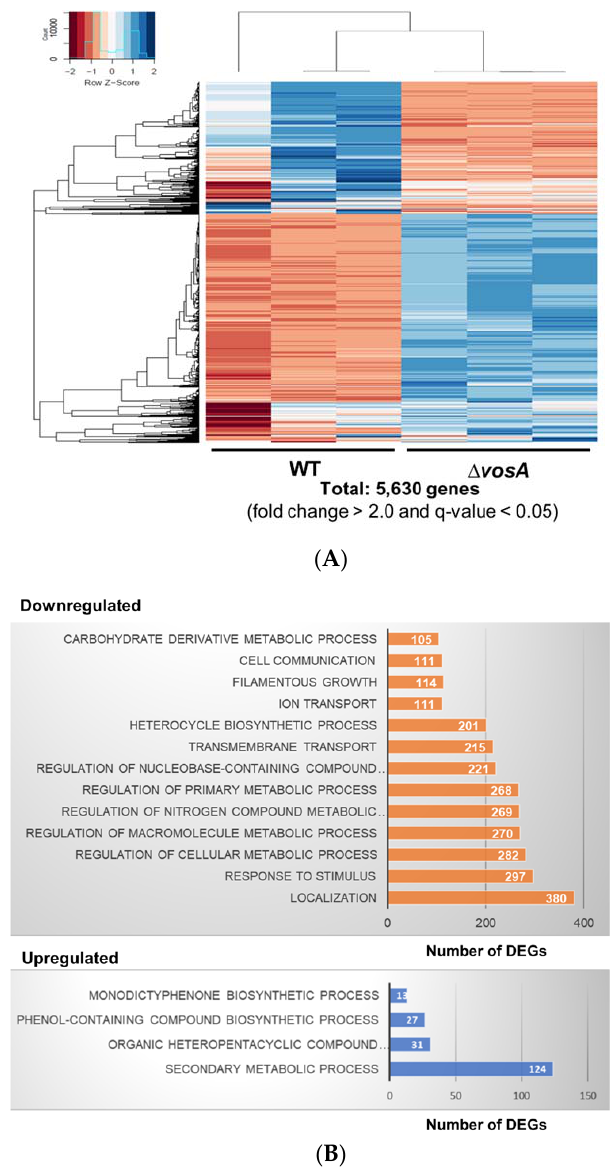
Figure 2. Genome-wide analyses of genes whose expression is a ff ected by VosA in ascospores. Figure 2. Genome ‐ wide analyses of genes whose expression is affected by VosA in ascospores. ( A ) ( A ) Hierarchical clustering analysis of di ff erentially expressed genes (DEGs) between WT and ∆ vosA Hierarchical clustering analysis of differentially expressed genes (DEGs) between WT and Δ vosA ascospores (fold change > 2.0 and q ‐ value < 0.05) is presented. ( B ) Gene Ontology (GO) term ascospores (fold change > 2.0 and q -value < 0.05) is presented. ( B ) Gene Ontology (GO) term enrichment enrichment analysis of DEGs in the Δ vosA ascospores. analysis of DEGs in the ∆ vosA